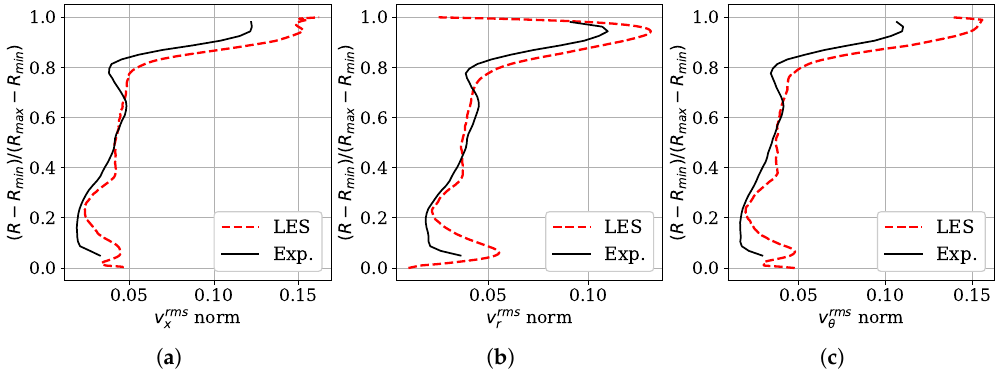
Figure 6. Normalized RMS meridional profiles of the velocity fluctuations: ( a ) axial; ( b ) radial; ( c ) tangential.